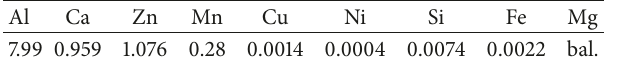
Table 1: Chemical composition (mass%) of the Mg-8Al-1Zn-1Ca alloy. Al Ca Zn Mn Cu Ni Si Fe Mg 7.99 0.959 1.076 0.28 0.0014 0.0004 0.0074 0.0022 bal.